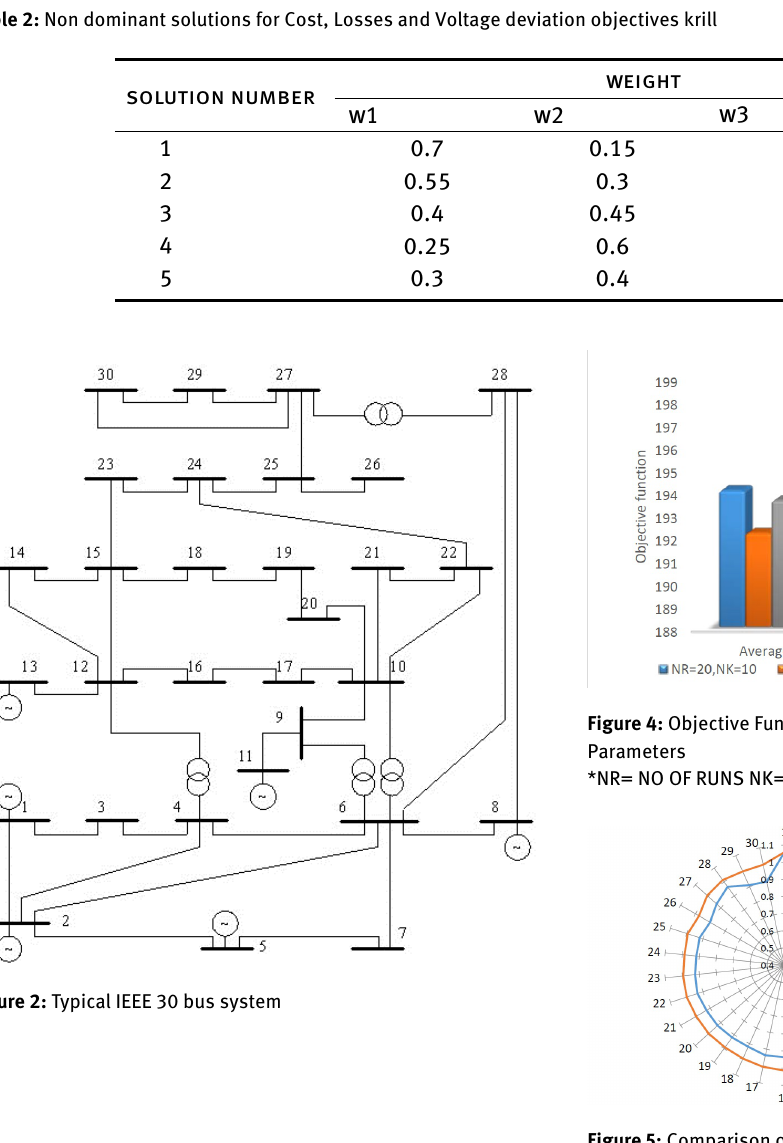
Figure 5: Comparison of voltage magnitude of optimal power flow without and with